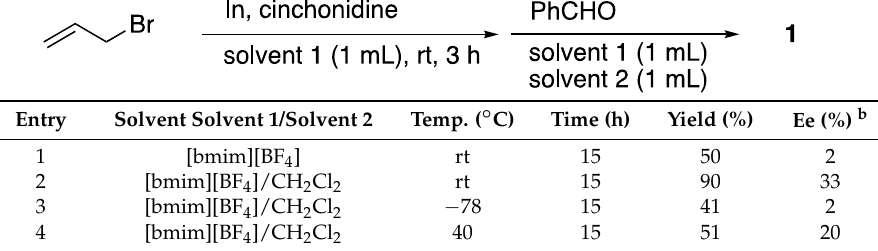
Table 5. Asymmetric indium ‐ mediated allylation of benzaldehyde using cinchonidine a .